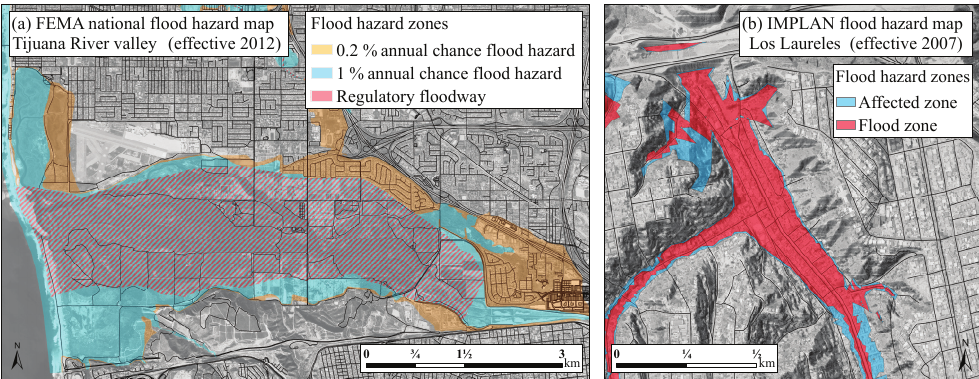
Figure 2. (a) Federal Emergency Management Agency flood insurance rate map for the Tijuana River valley. The orange area represents the flooding extent associated with the 0.2% annual exceedance probability (AEP) flood, while the blue area represents the flooding extent of the 1% AEP flood. The red hashed area delineates the regulatory floodway, where development must not increase the designated base flood elevation by more than 0.3m (1ft). (b) IMPLAN flood hazard map for the Los Laureles subbasin. The red and blue zones represent inundation extent for different exceedance probability flooding events. However, details regarding mapping methodology and precise hazard zone explanations were not